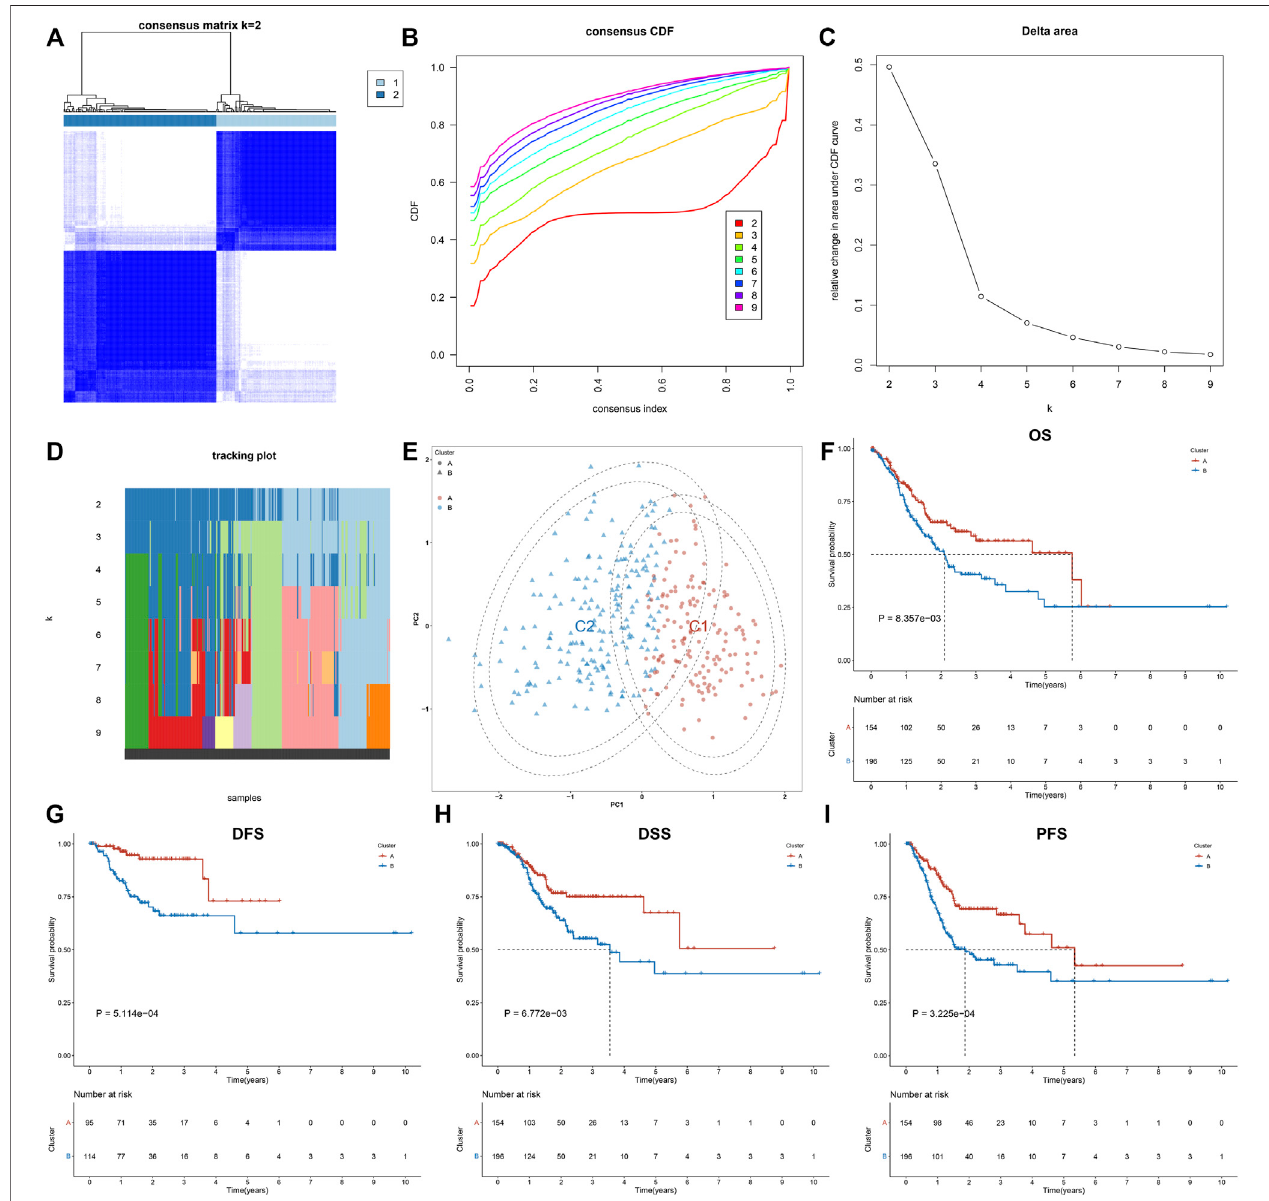
FIGURE1| Constructionoftwoexosome-relevantphenotypeswithdistinctclinicaloutcomesinGC. (A) ConsensusscorematrixofGCspecimenswhenk=2. (B) CDF of the consensus matrix for each k (indicated by colors). (C) Relative alterations in the area under CDF curves. (D) Tracking plot for each k. (E) PCA plot by expressionpro fi lingof15prognosticexosome-relatedgenes.Eachpointindicateseachspecimen,withuniquecolorsrepresentingexosome-relevantphenotypes. (F – I) Kaplan – Meier analysis of (F) OS, (G) DFS, (H) DSS, and (I) PFS in two exosome-relevant phenotypes.